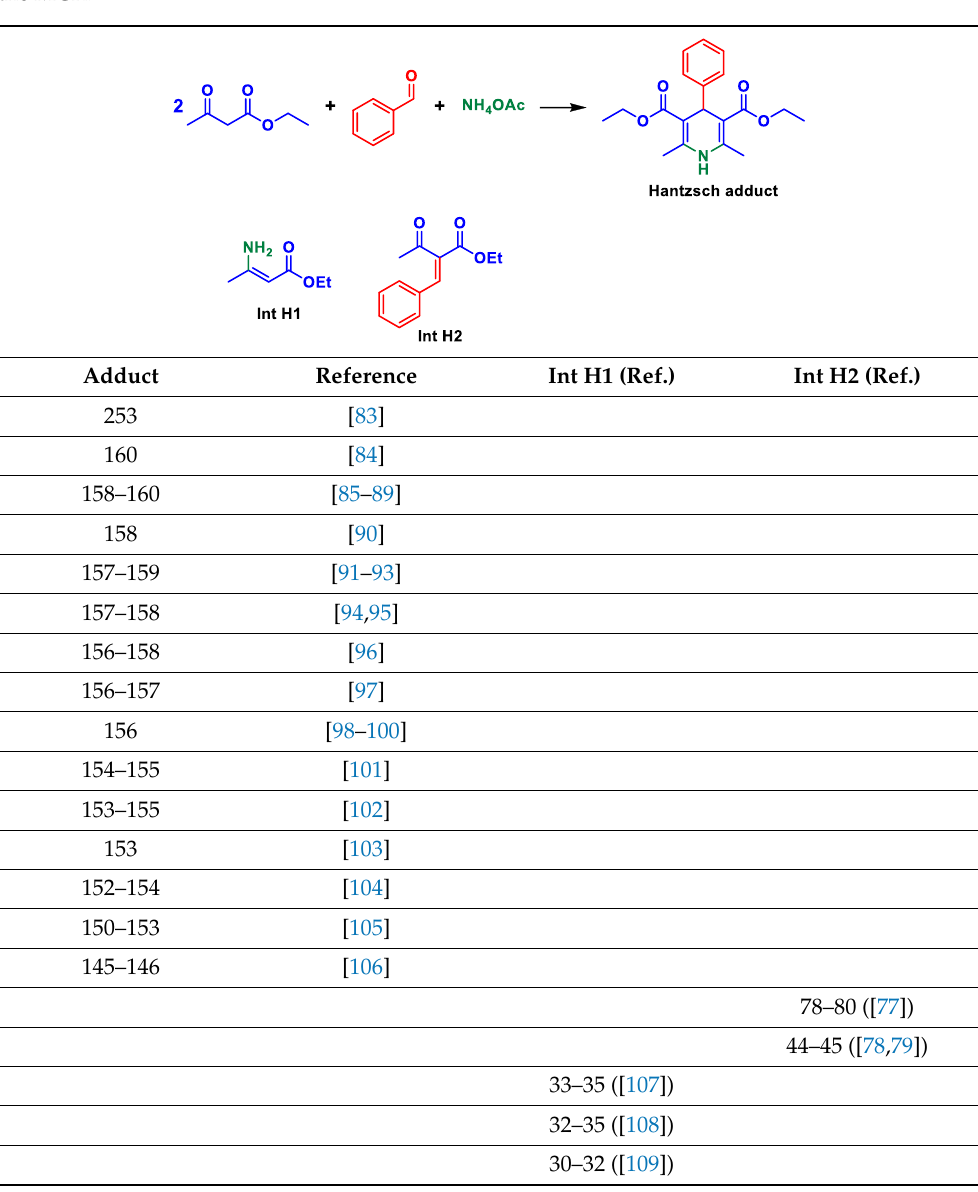
Table 2. Reported mps (°C) for the Hantzsch ester derivative and some reaction intermediates of the MCR.